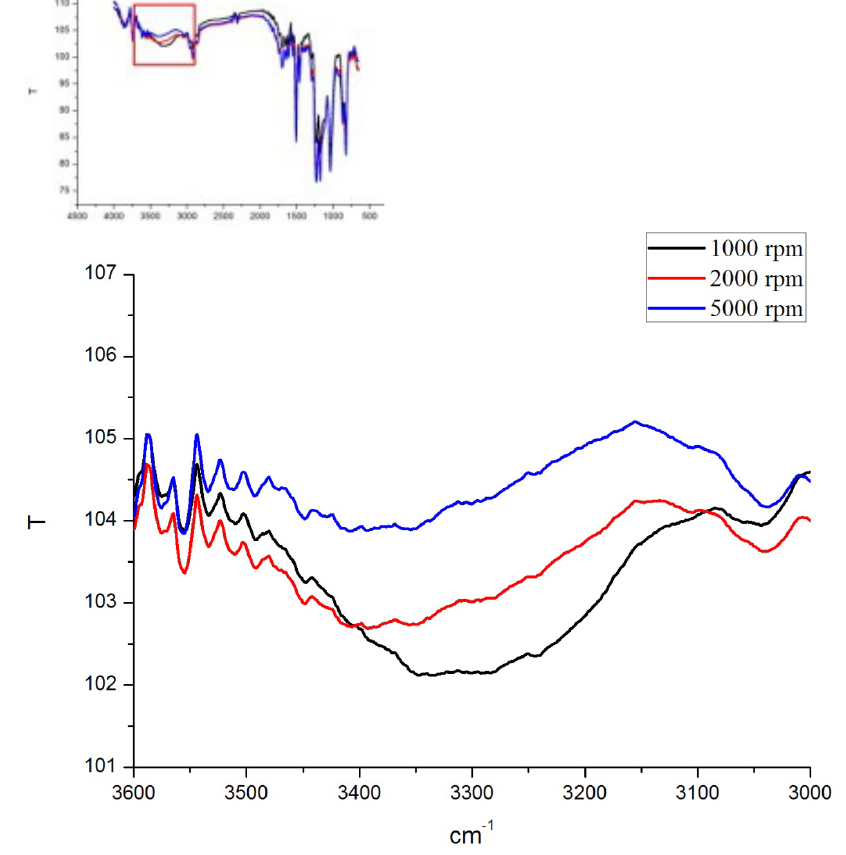
Figure 10. O-H stretching signal of water at day 31 of aging in the three resin samples.